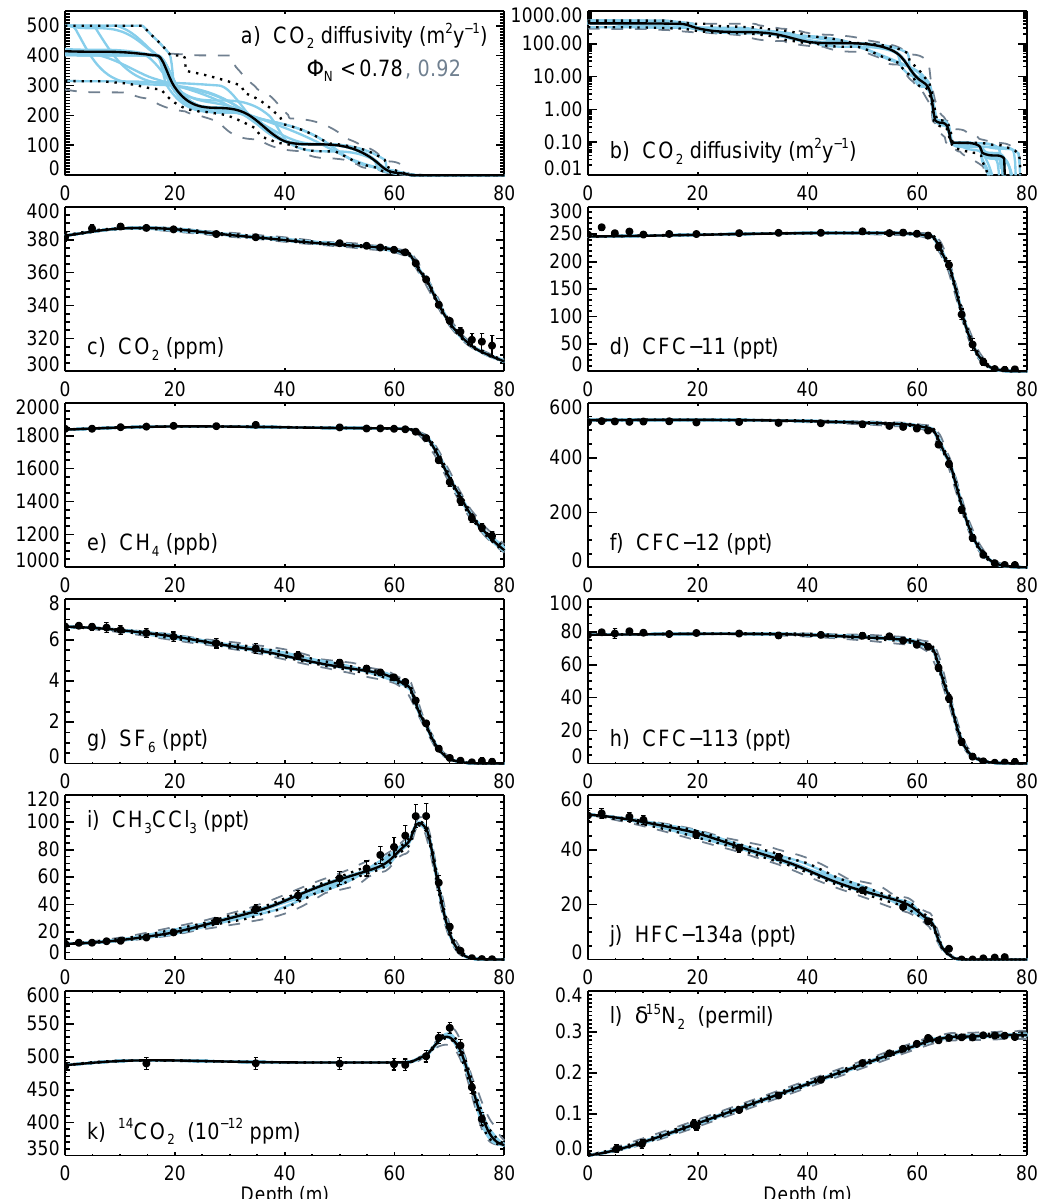
Fig. 6. CO 2 diffusivity and concentration profiles from calibration with all ten NEEM reference tracers from Buizert et al. (2012), with convective mixing modelled by exponentially-decreasing eddy diffusion (TenEddy). Results are for 8 N < 0 . 78 except for the blue dashed lines which are for 8 N < 0 .